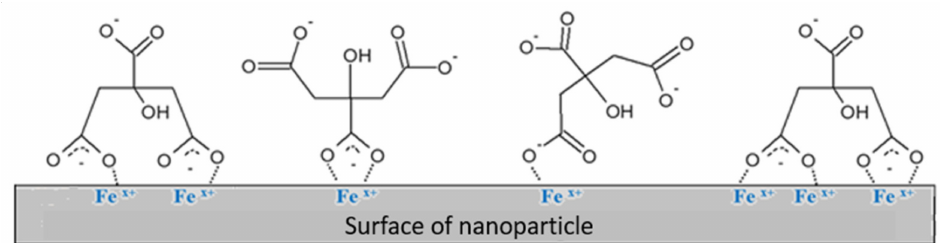
Figure 9. Schema several possible binding modes between the citrate ligands and the surface an iron oxide